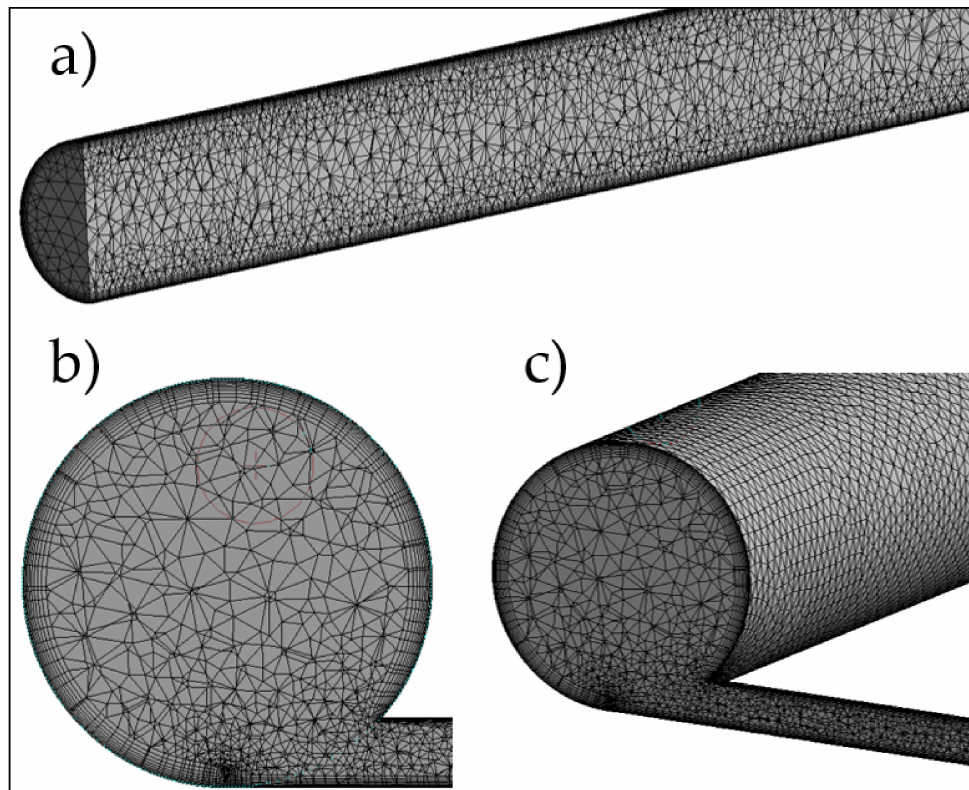
Figure 3. Basic model with visible “inflation layer”. ( a ) Meshing of the reaction tube; ( b ) cross-section view of side inlet meshing; ( c ) side view of the side inlet.